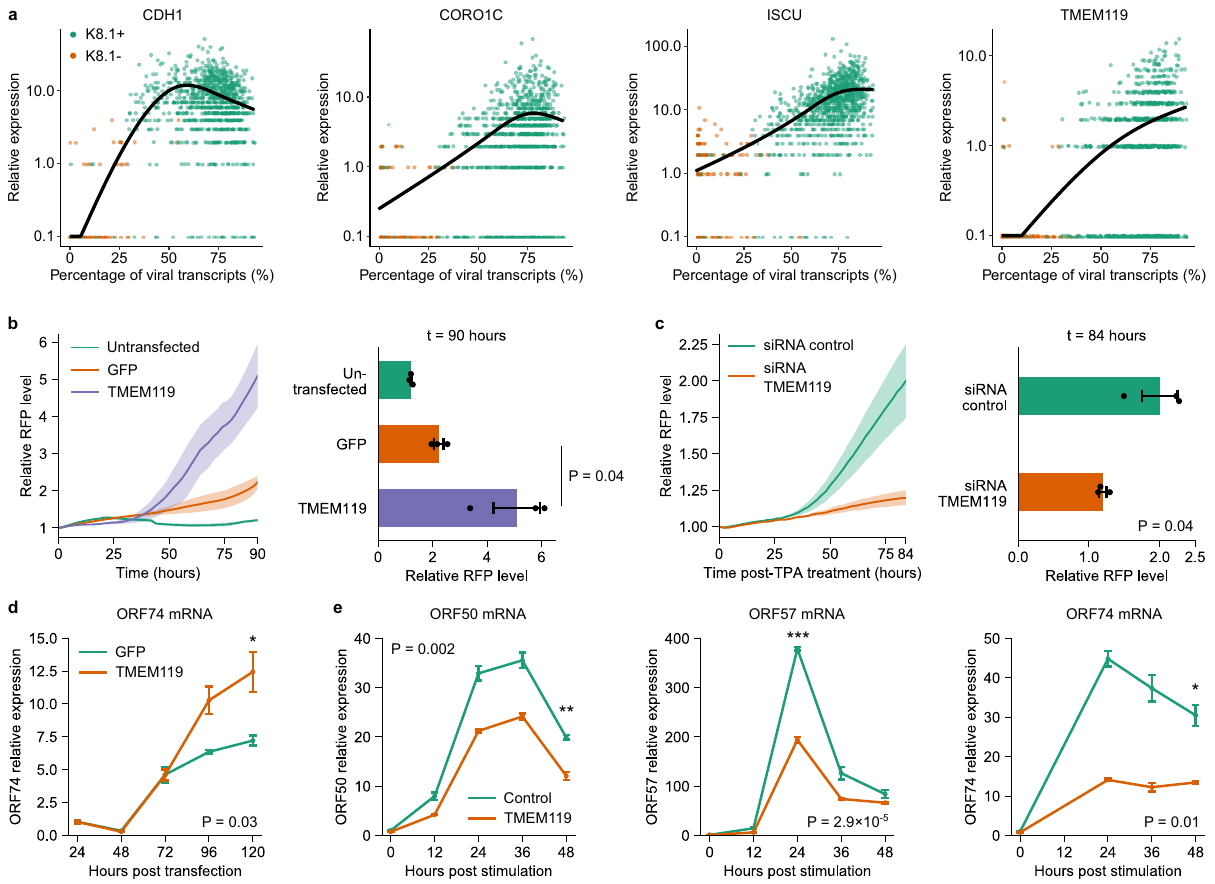
Fig. 4 FD-seq identi fi es TMEM119 as a potential host factor that mediates KSHV reactivation. a Plots showing the relative expression of the four host factors CDH1 , CORO1C , ISCU , and TMEM119 (based on the genes ’ normalized counts) as a function of the percentage of KSHV transcripts. Each dot indicates a single cell. b Live-cell imaging analysis of RFP expression, which is indicative of KSHV reactivation level, in untransfected HEK293T.rKSHV219 cells or cells transfected with TMEM119 or GFP control (left), and end-point quanti fi cation of RFP expression at 90 h (right). c Live-cell imaging analysis of RFP expression in HEK293T.rKSHV219 cells transfected with control or TMEM119 -targeting siRNAs for 48 h, followed by treatment with 2 ng/mL TPA (left), and end-point quanti fi cation of RFP expression at 84 h (right). In b , c , the lines indicate the mean, and the ribbons indicate the s.e.m. of the data. d Time-course RT-qPCR analysis of KSHV ORF74 abundance in HEK293T.rKSHV219 cells transfected with TMEM119 or GFP control. e Time-course RT- qPCR analysis of KSHV ORF50 , ORF57 , and ORF74 levels in HEK293T.rKSHV219 cells transfected with control or TMEM119 -targeting siRNAs. b – e Data are represented as mean ± s.e.m. n = 3 biological replicates per sample. d , e * P < 0.05, ** P < 0.01, *** P < 0.001 (one-sided Welch ’ s t